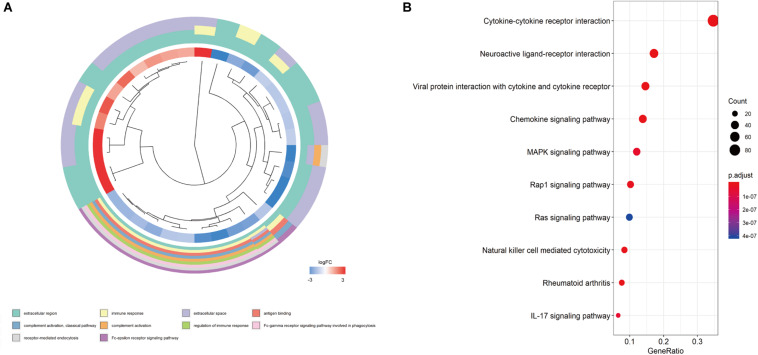
Functional enrichment of differentially expressed IRGs. (A) Gene Ontology analyses; the red region represents upregulated IRGs, and the blue region represents downregulated IRGs. (B) The top 10 most significant Kyoto Encyclopedia of Genes and Genomes pathways.